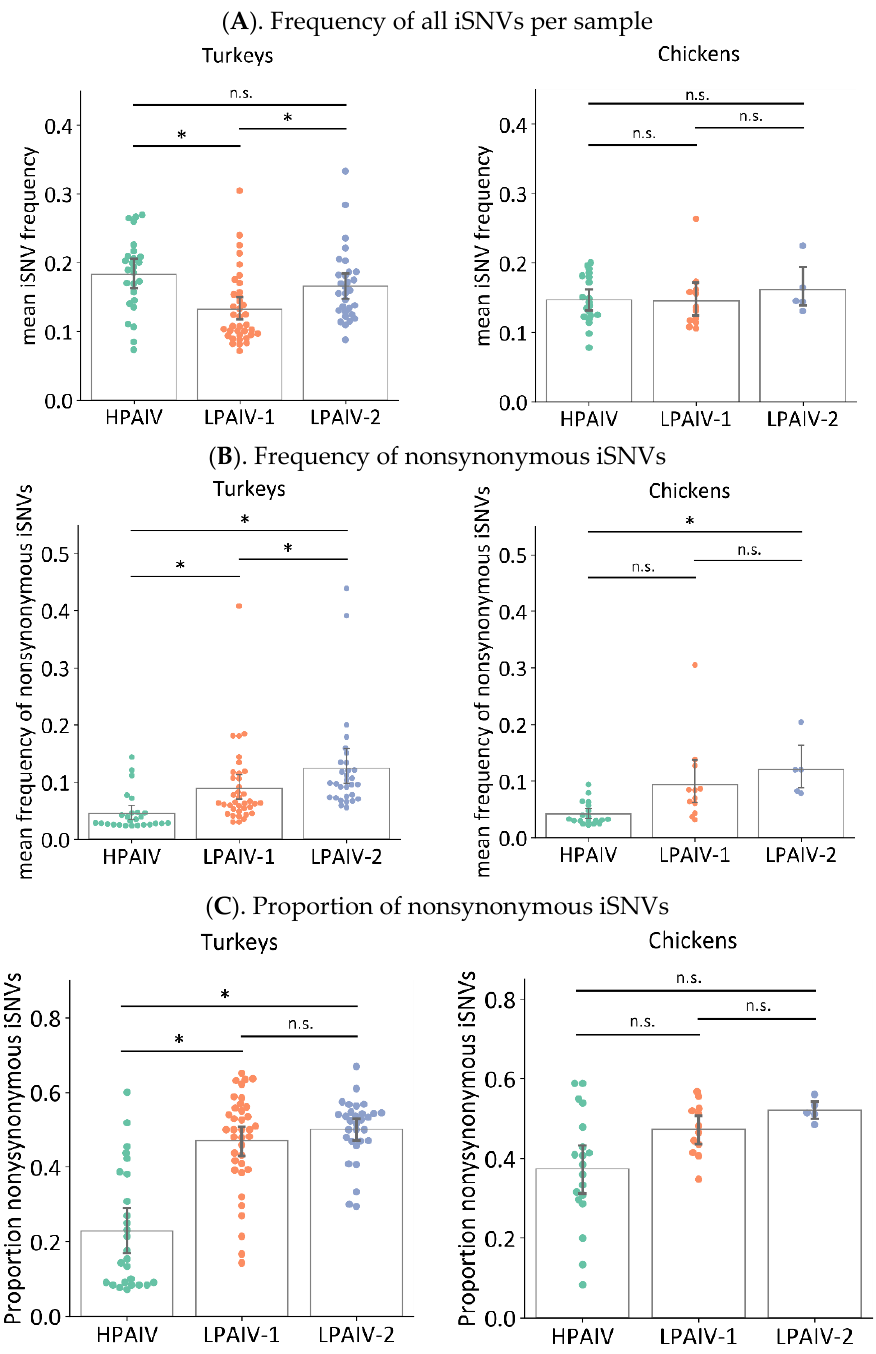
Figure 3. The iSNVs found in OP swabs from inoculated turkeys and chickens were classified according to whether the iSNV resulted in a change in amino acid (nonsynonymous) or not (synonymous). The overall mean iSNV frequency, regardless of whether it is nonsynonymous, was then calculated for each swab sample and compared among the three virus groups ( A ). To determine whether iSNVs from different virus groups resulted in different levels of nonsynonymous changes, the mean frequency ( B ) and proportion ( C ) of nonsynonymous changes were calculated. Asterisks (*) indicate p < 0.05 for indicated groups using Kruskal – Wallis and Dunn ’ s post hoc test for multiple comparisons. n.s. = not significant with p ≥ 0.05.